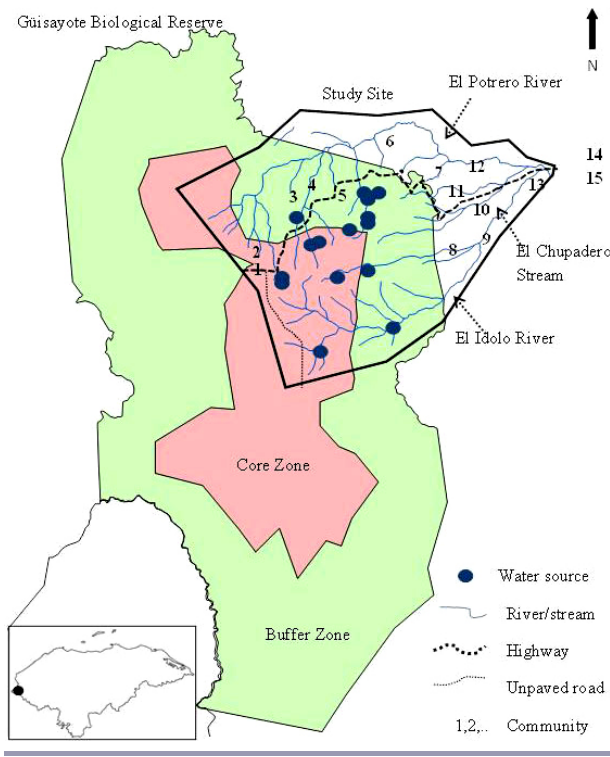
Fig. 1 . Güisayote Biological Reserve showing the study site (solid black outline), rivers, water sources, and roads in the reserve. Inset shows location of the reserve in